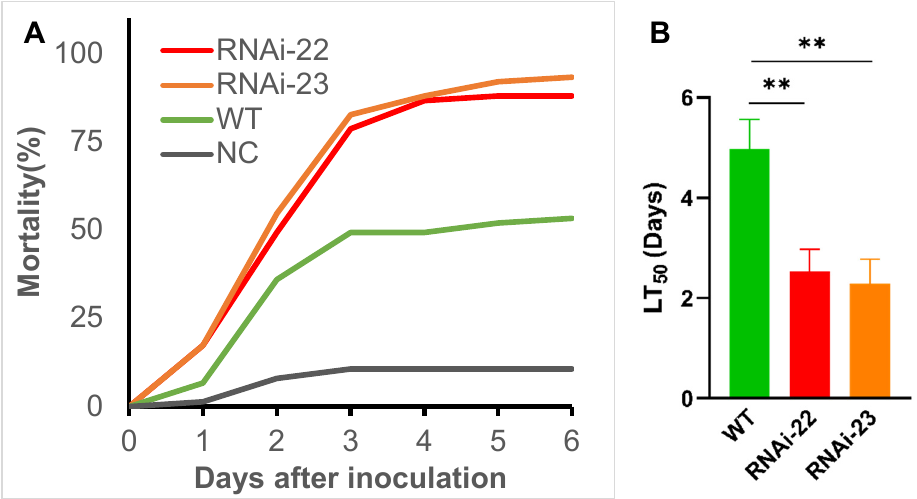
Figure 3. Expression of dsRNA in M. anisopliae targeting NlCHSA increases its virulence to N. lugens . ( A ) Survival curves of N. lugens after infection by dsRNA expressing M. anisopliae strains 22 and 23 (RNAi-22 and RNAi-23) as well as wild type (WT). N. lugens 4th nymphs were sprayed with M. anisopliae suspended in 0.1% Tween 80 at concentration of 1.6 × 10 7 conidia/mL. Negative control (NC) insects were sprayed with 0.1% Tween 80 alone. The data represent the mean of three independent experiments. ( B ) Median lethal time (LT 50 ) of M. anisopliae WT, RNAi-22 and RNAi-23 strains against N. lugens . Probit survival analyses were used to calculate LT 50 . ** means p <